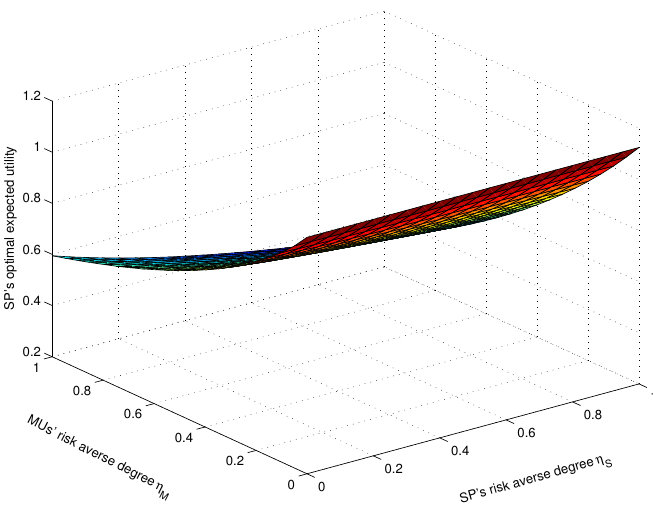
Figure 7. Service provider’s (SP’s) optimal expected utility for fixed σ 2 = 0.5 and ¯ U = 0.